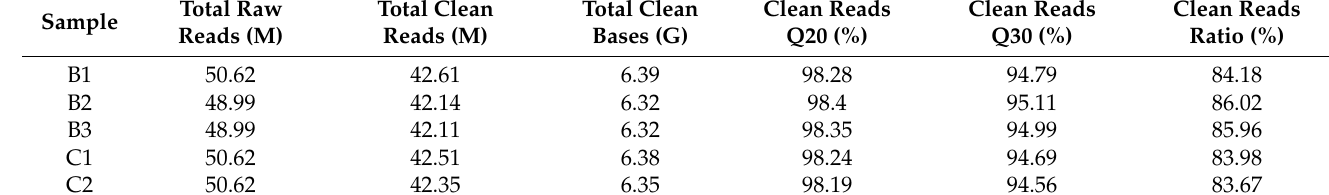
Table 2. Transcriptional sequence analysis of leaf samples of the control group and domesticated R. chrysanthum .